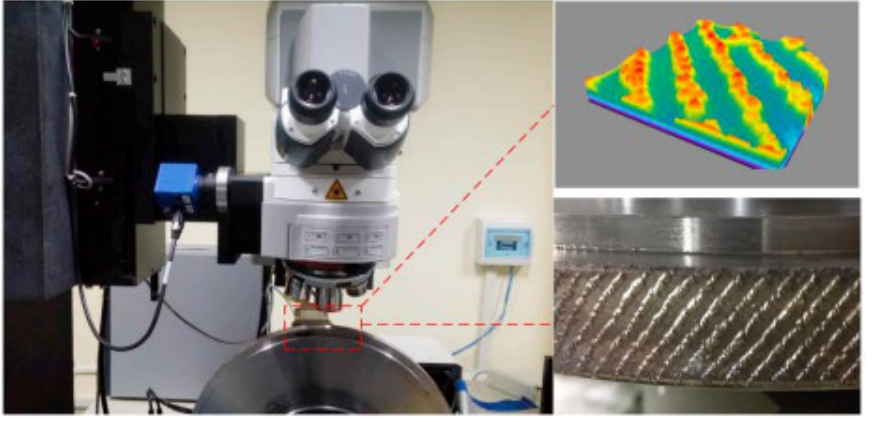
Figure 7. Topography of a monolayer abrasive grinding wheel with an arrangement pattern [53].